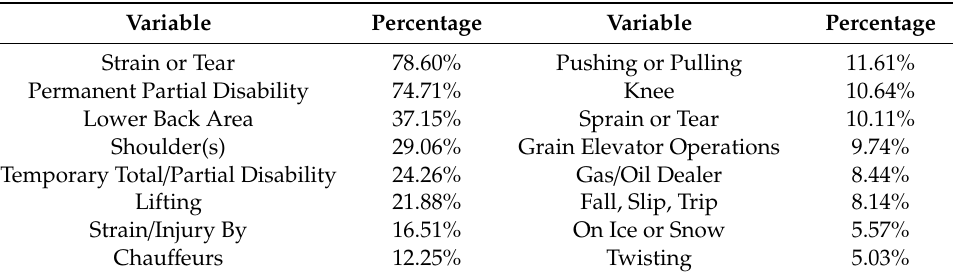
Table 5. Characteristics of injury patterns in class 1.